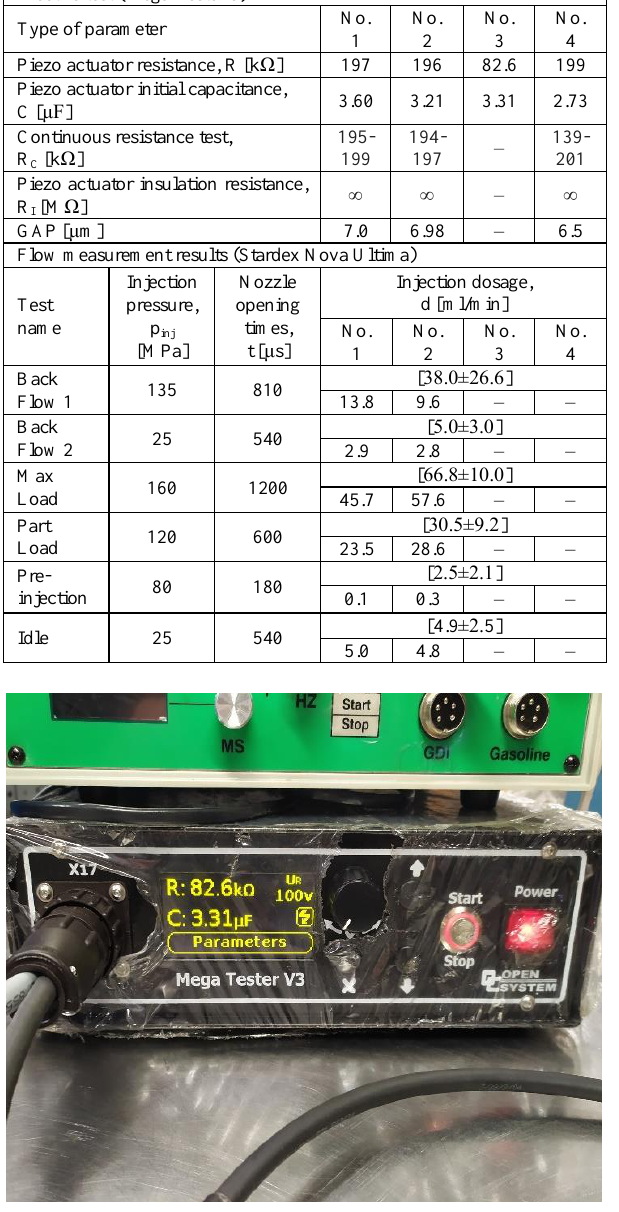
Fig. 4. Failure of the piezoelectric actuator (fuel injector No. 3)